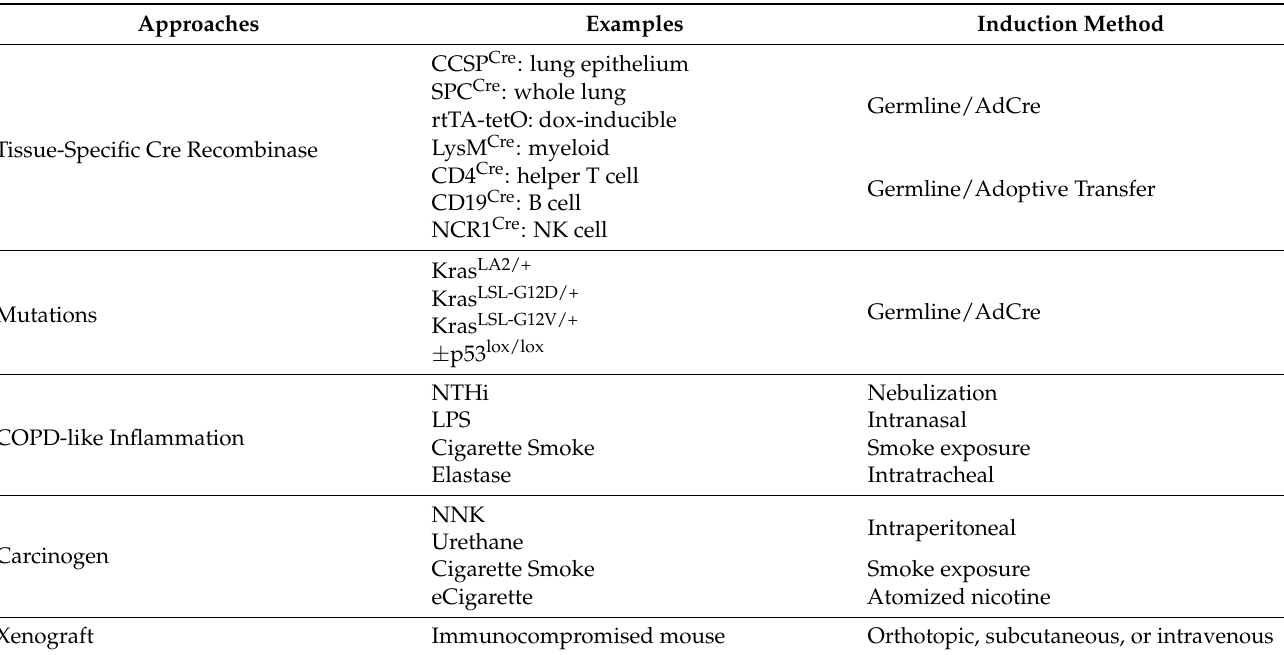
Table 1. Mouse models available to study STAT3 in